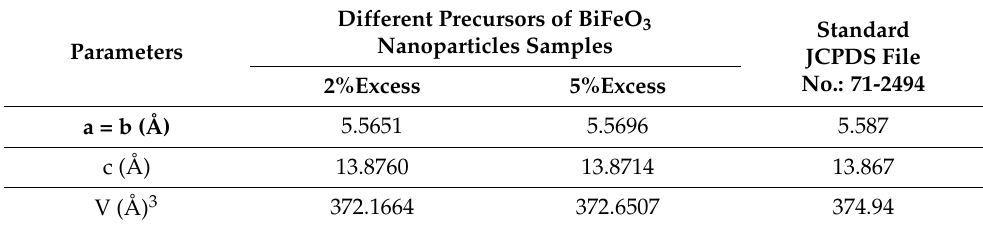
Table 1. Cell parameters of BiFeO 3 Nanoparticles.